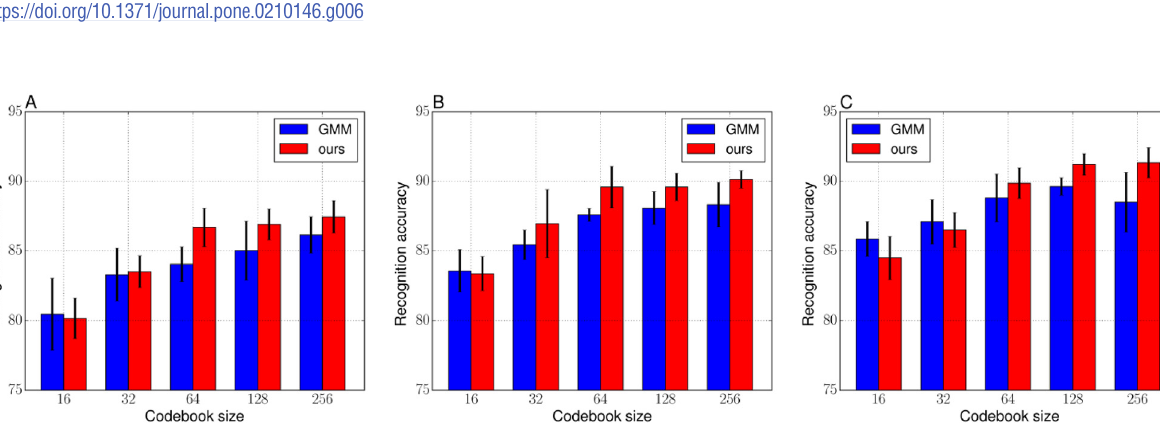
PLOS ONE | https://doi.org/10.1371/journal.pone.0210146 January 10,